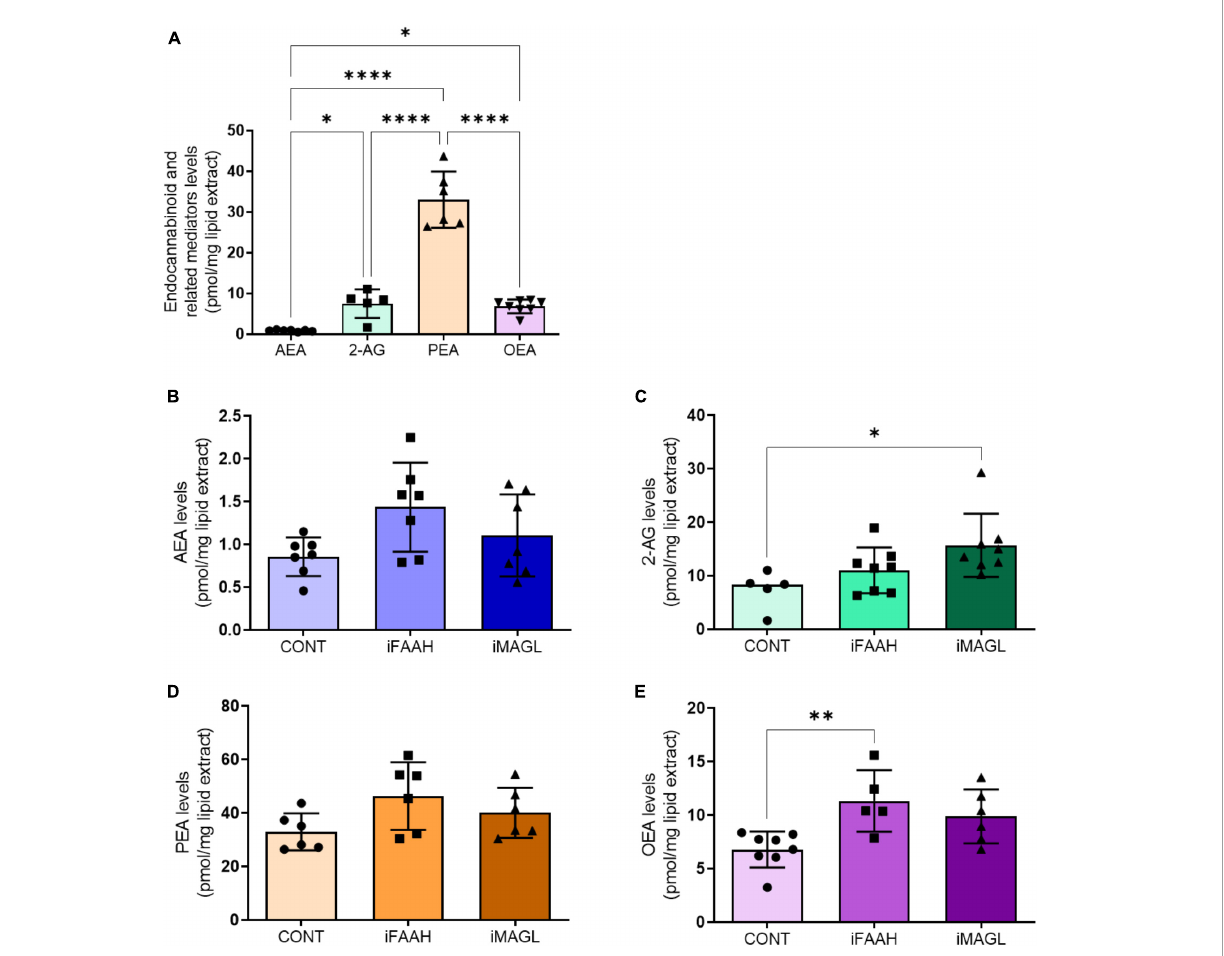
FIGURE2 OEG cell cultures release endocannabinoids to OEGCM. In panel (A) , anandamide (AEA, N = 7) and 2-arachidonoylglycerol (2-AG, N = 5), and related mediators palmitoylethanolamide (PEA, N = 6) and oleoylethanolamide (OEA, N = 8) levels in the olfactory ensheathing glia conditioned medium (OEGCM) ( p = 0.0368 for AEA vs. 2-AG; p < 0.0001 for AEA vs. PEA; p = 0.0334 for AEA vs. OEA; p < 0.0001 for 2-AG vs. PEA; p = 0.9998 for 2-AG vs. OEA; p < 0.0001 for PEA vs. OEA). In panels (B–E) , levels of endocannabinoids and related mediators after treatment with URB597 10 - 9 M (iFAAH) or JZL184 10 - 9 M (iMAGL) for 3 days before lipid analysis. Data is presented as mean ± SD, statistical analysis was performed using One-way ANOVA and Tukey’s as post hoc test. (B) N = 7 for all experimental groups, p = 0.0527 for CONT vs. iFAAH, p = 0.5351 for CONT vs. iMAGL; (C) Control: N = 5, iFAAH: N = 8, iMAGL: N = 8, p = 0.4139 for CONT vs. iFAAH, p = 0.0202 for CONT vs. iMAGL; (D) N = 6 for all experimental groups, p = 0.0817 for CONT vs. iFAAH, p = 0.4486 for CONT vs. iMAGL; (E) Control: N = 8, iFAAH: N = 5, iMAGL: N = 6, p = 0.0084 for CONT vs. iFAAH, p = 0,0587